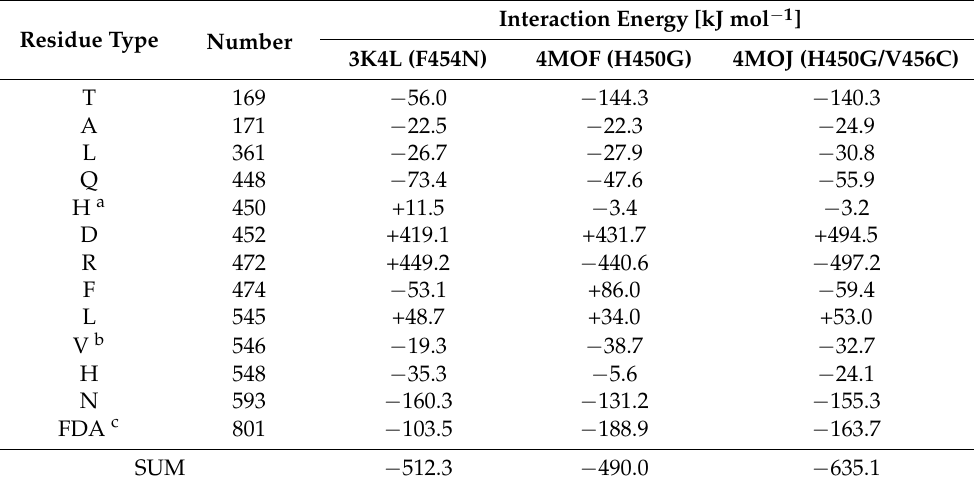
Table 2. Electrostatic interaction energies (kJ mol − 1 ) between 2-FG and residues in the binding pocket for chosen ligand-protein complexes. A type of point mutation(s) is provided in parentheses.